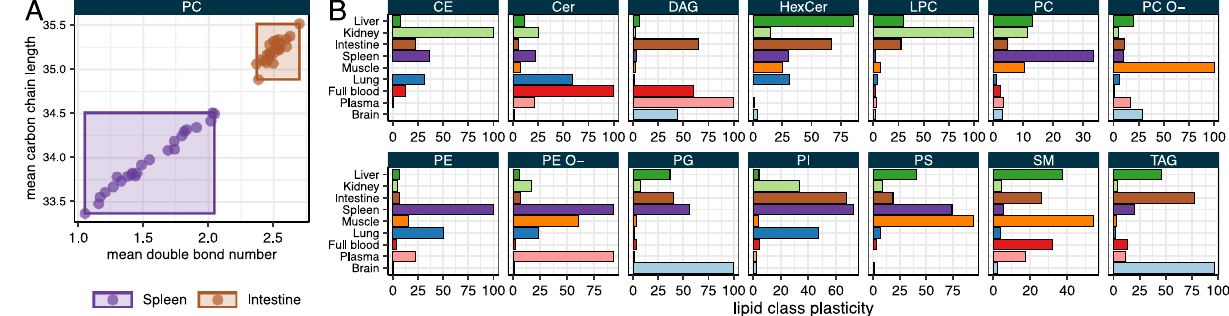
Figure 3. Lipid class plasticity across all combinations of experimental conditions. ( A ) Plasticity is calculated per class and organ by multiplying the scaled ranges of values of weighted mean number of double bonds and the weighted mean number of carbons in the hydrocarbon chain moiety per lipid class. The wider the ranges, the higher the plasticity. ( B ) Lipid class plasticity for the different mouse organs. For details see Materials &